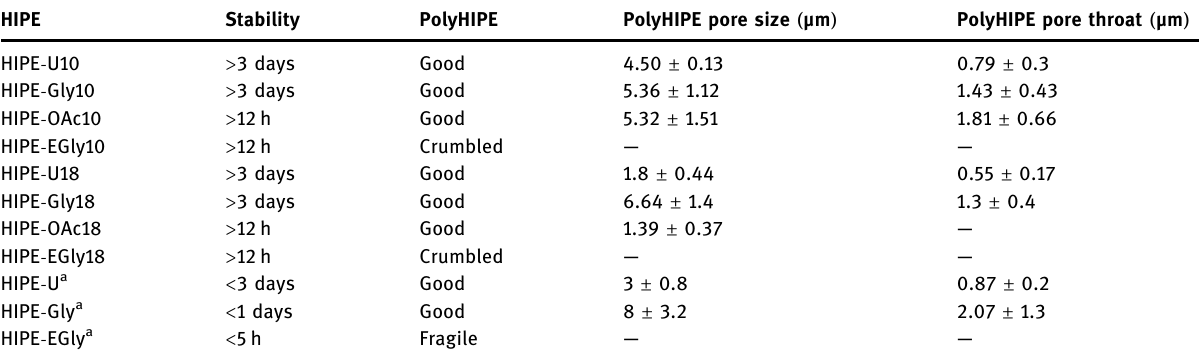
Table 1: Stability of HIPEs and polyHIPEs by visual observation and pore size and pore throat size of polyHIPEs HIPE